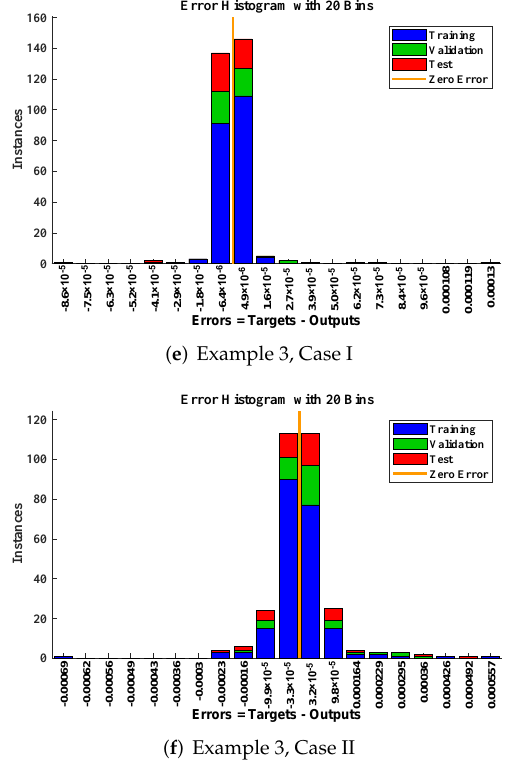
Figure 12. Error histograms, representing absolute errors between the reference solution and the approximated solution for different examples of the rolling motion of ships in random beam seas.